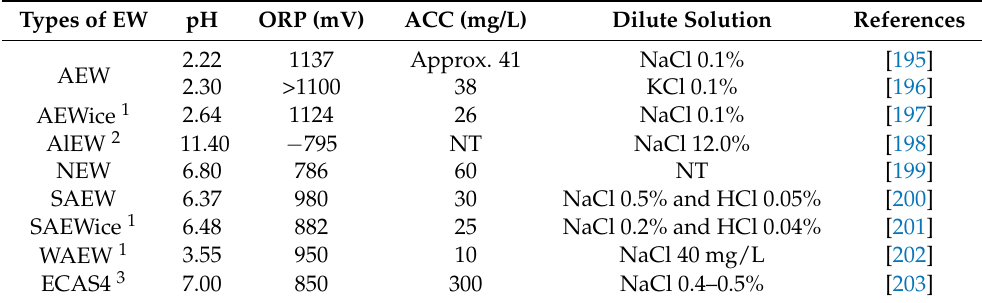
Table 4. Types and physicochemical properties of electrolyzed water EW used on fish and seafood